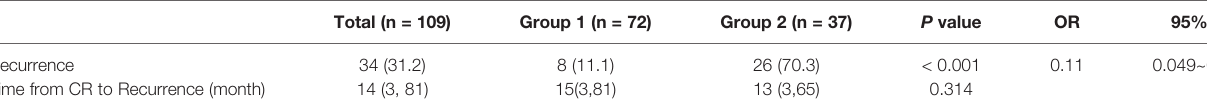
TABLE 2 | Recurrence comparison of Group 1 and Group 2 (%).